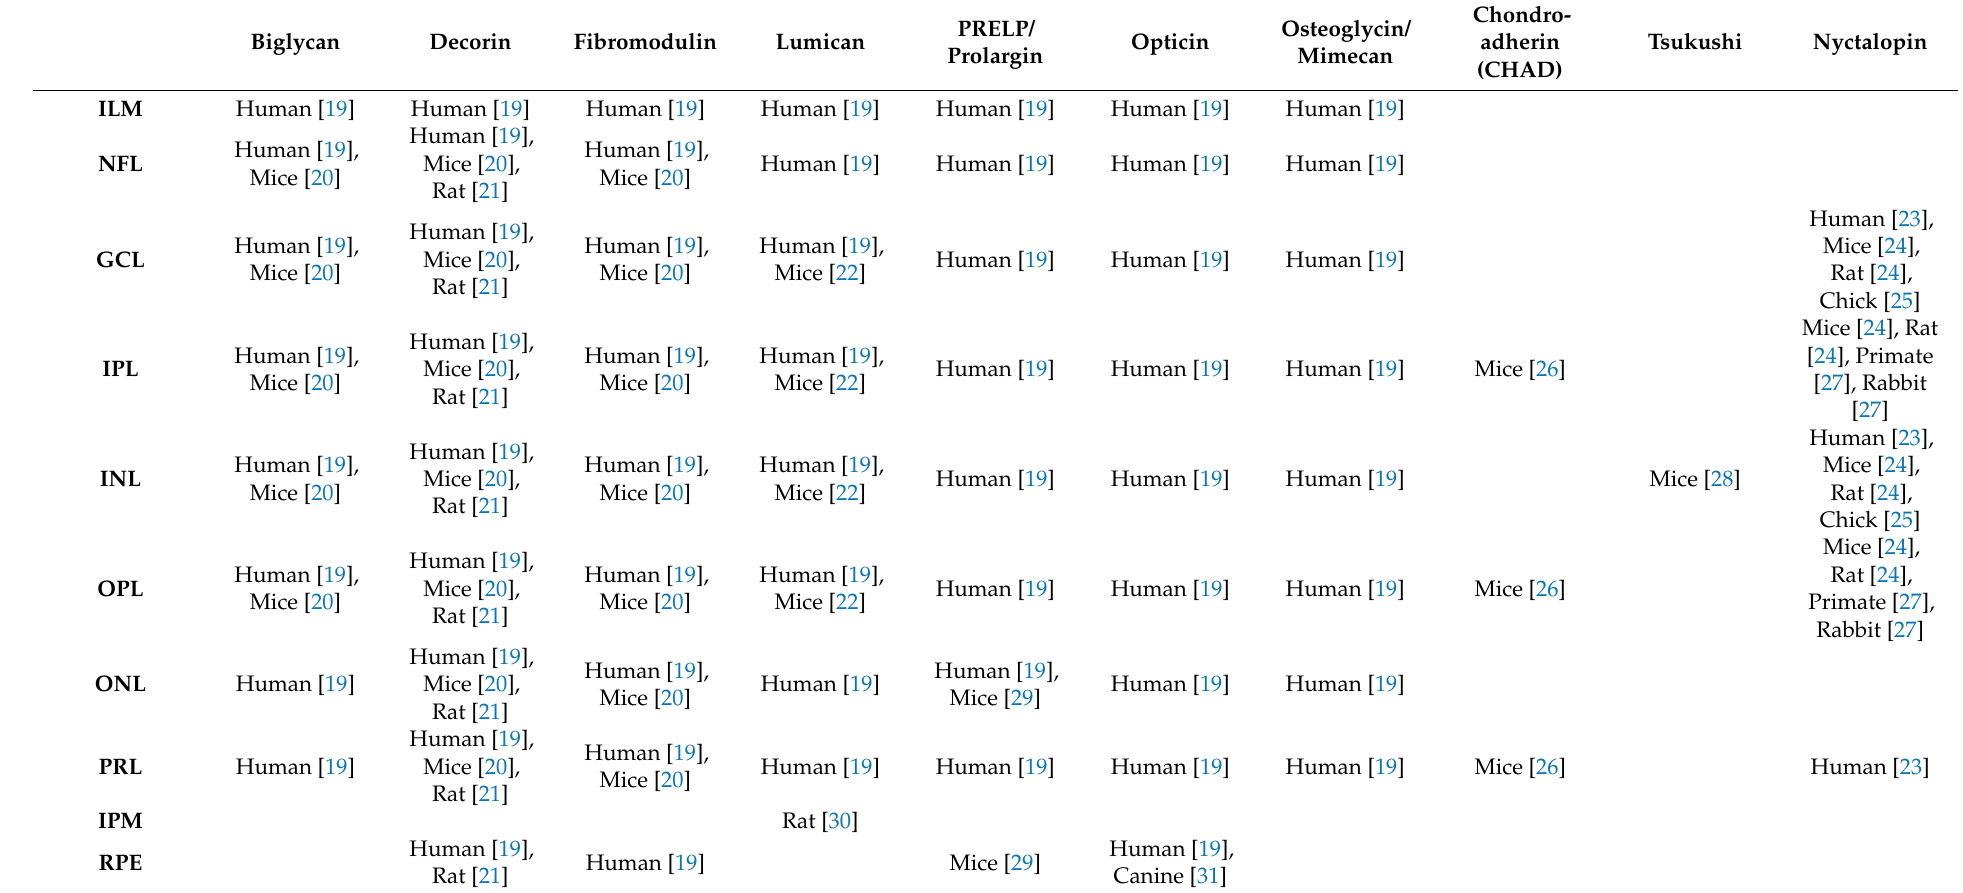
Table 1. Distribution of SLRPs in the